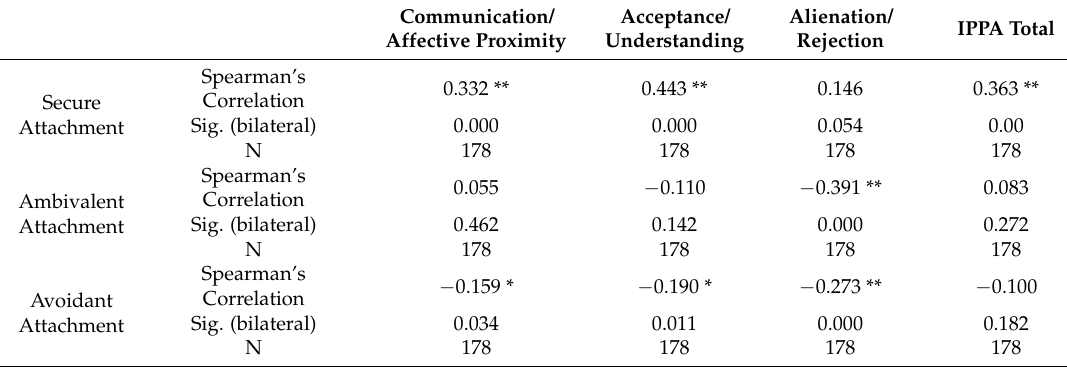
Table 4. Childhood-Attachment subscale (IACA) and the student–teacher relations subscale (IPPA), regarding the